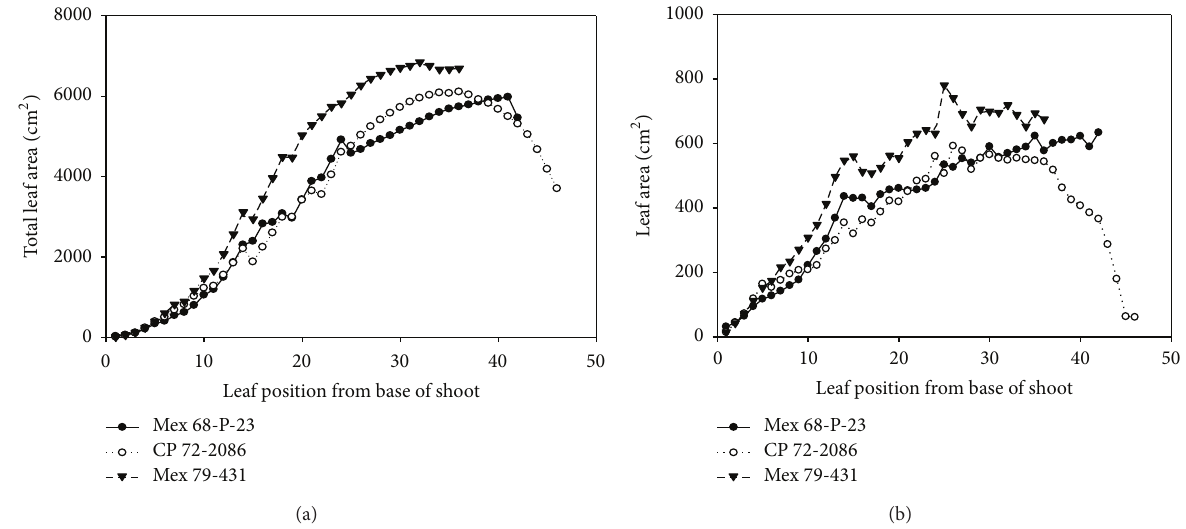
Figure 1: Total leaf area (a) and individual leaf area (b) in the field experiment for the three sugarcane cultivars tested under high temperature rainfed conditions in Northeastern